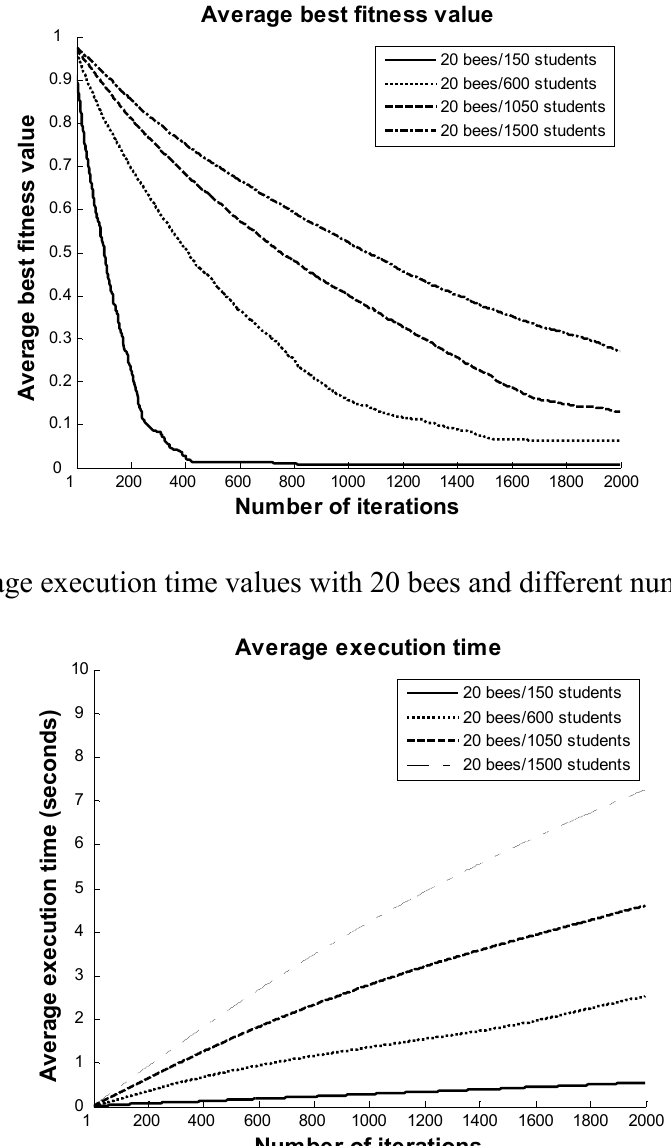
Figure 10. Average best fitness values with 20 bees and different numbers of students.